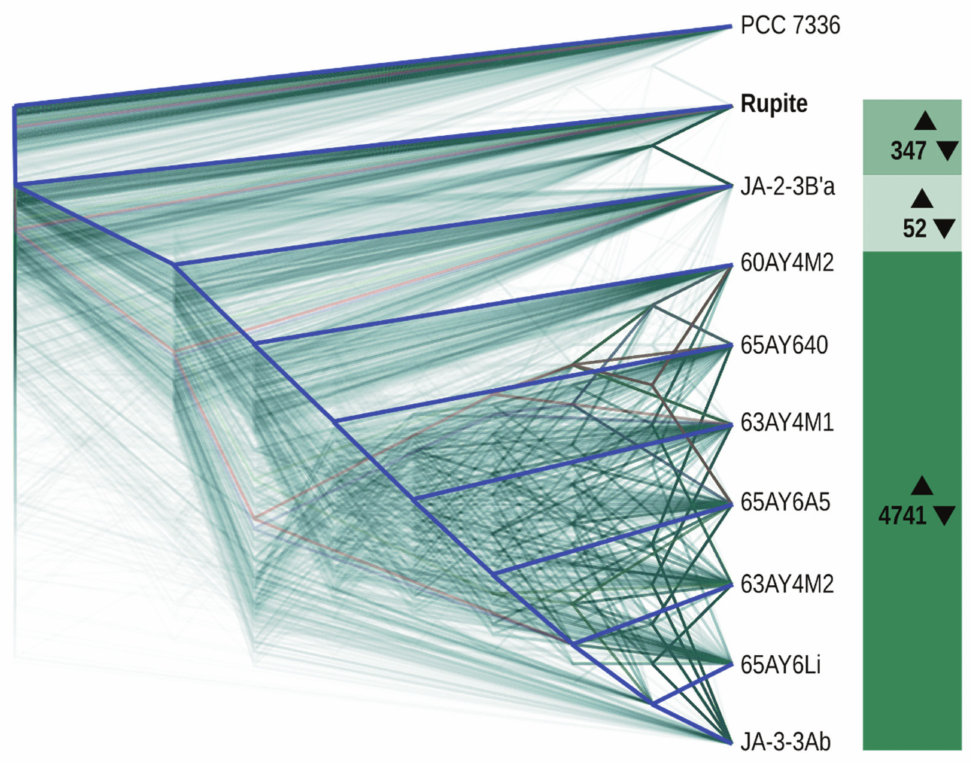
Figure 2. The Densitree visualization of the 1513 maximum likelihood phylogenetic trees. The thickened line represents the root canal—consensus tree with the highest support. The HGT frequency and direction estimated by T-Rex for each species are visualized by arrows and